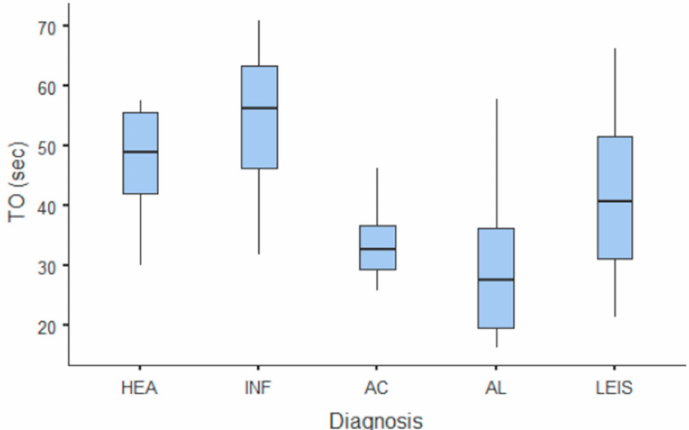
Figure 6. Box and whisker plot of the time to fall (TO) for healthy (HEA), inflammatory (INF), adenocarcinoma (AC), lymphoma (AL), and leiomyosarcoma